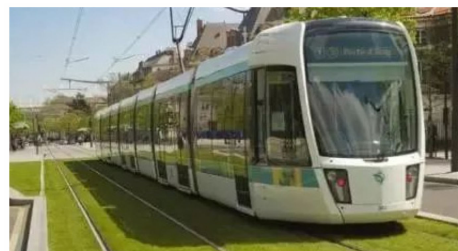
Figure 1. Modern tram.